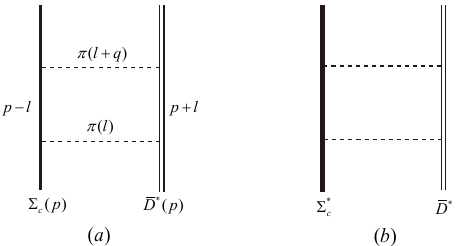
Figure 1 . Two typical Feynman diagrams for the two-pion-exchange process of the (cid:6) c (cid:22) D (cid:3) ( a ) and (cid:22) D (cid:3) ( b ) systems. We use the thick line, heavy-thick line, double-thin line and dashed line to (cid:6) (cid:3) c denote the (cid:6) c , (cid:6) (cid:3) , (cid:22) D (cid:3) and pion, respectively. c two-pion-exchange potential to some extent. In particular, the mass di(cid:11)erence (cid:14) between (cid:22) D (cid:3) and (cid:22) D is larger than the pion mass m . The heavy quark spin symmetry breaking (cid:25) e(cid:11)ect has been noticed for the charmed sectors in some works [11, 43]. Besides, one shall not neglect the role of (cid:3) , since the (cid:3) (cid:25) couples strongly with the (cid:6) ( (cid:3) ) c . Therefore, we c c